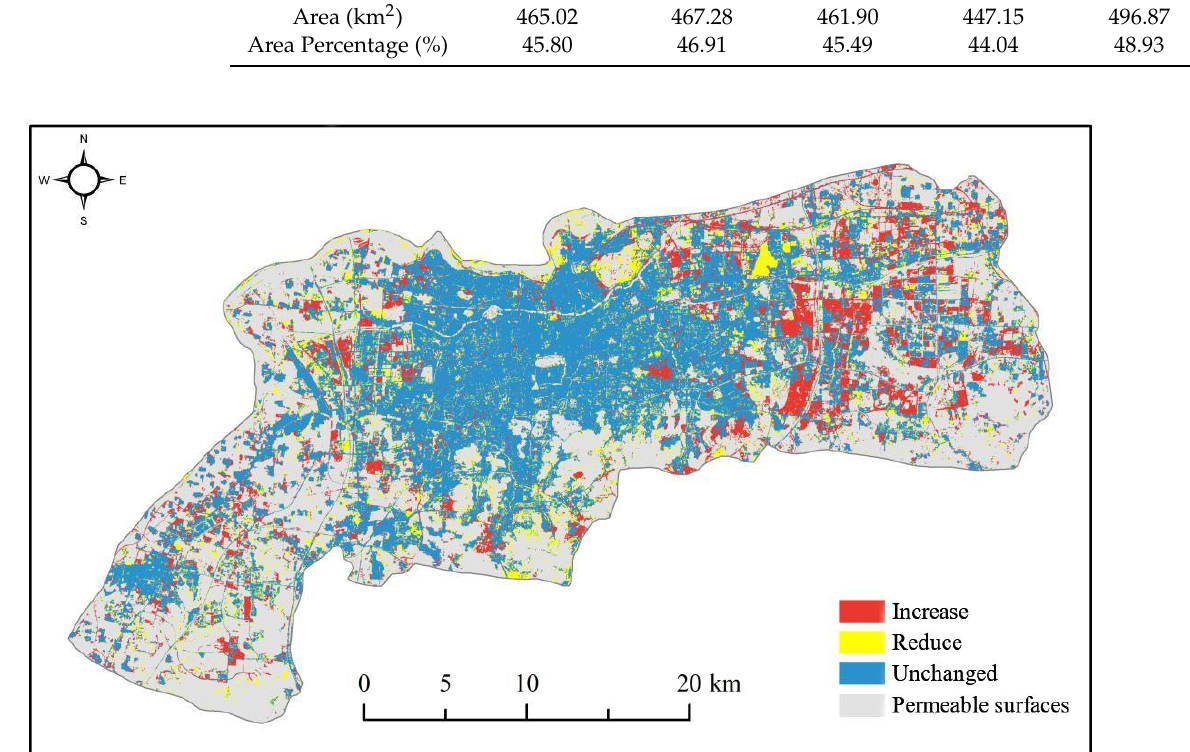
Figure 11. Change in the impervious surface increase and decrease from 2017 to 2021. Table 5. Statistics of the impervious surface area in the central city of Jinan, 2017 – 2021.